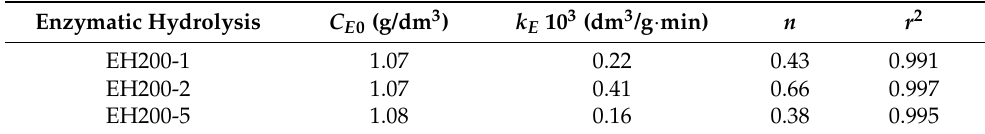
Table 5. Effects of LHW pre-treatment time on Chrastil’s model parameters.